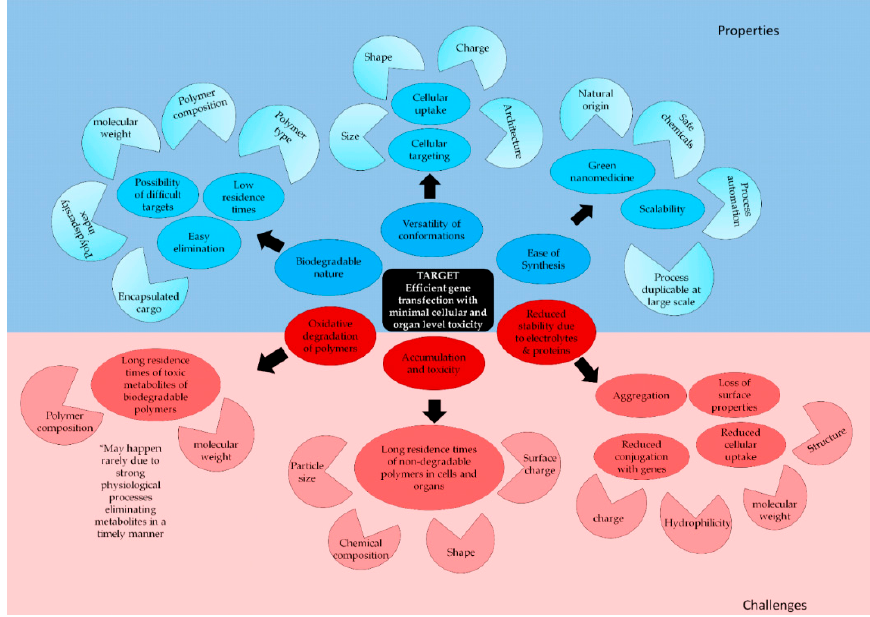
Figure 10. Summary of properties and challenges of polymeric nanoparticles for gene delivery and associated factors influencing each of these